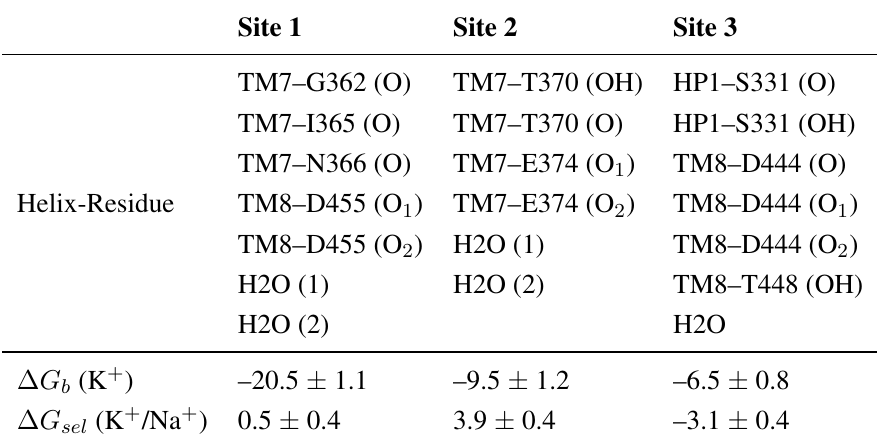
Table 3. EAAT3 residues coordinating the K + ion at three proposed binding sites, and their respective standard binding free energies and K + /Na + selectivity free energies (in units of